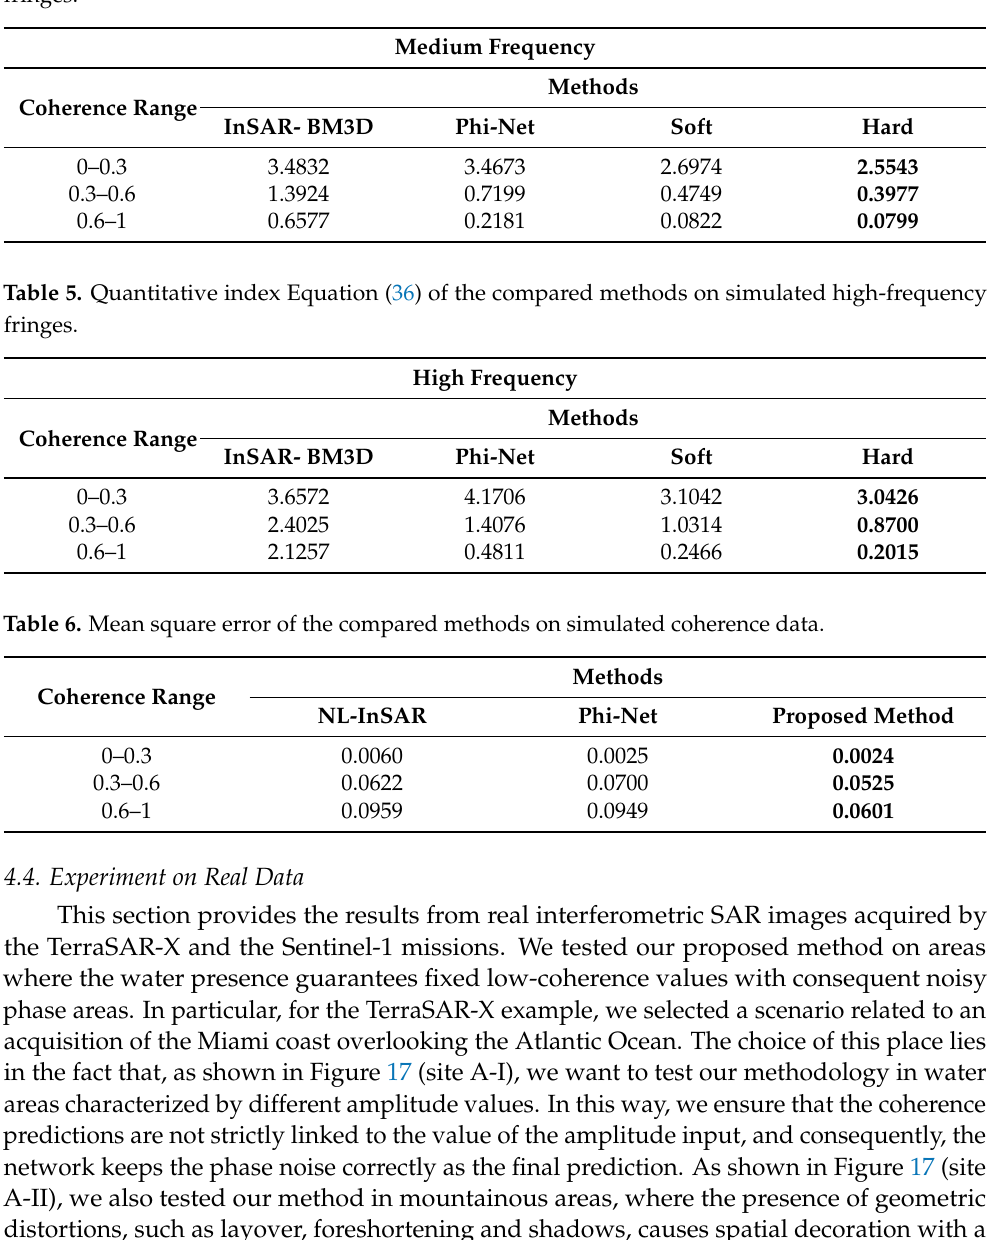
Table 4. Quantitative index Equation (36) of the compared methods on simulated medium-frequency fringes.